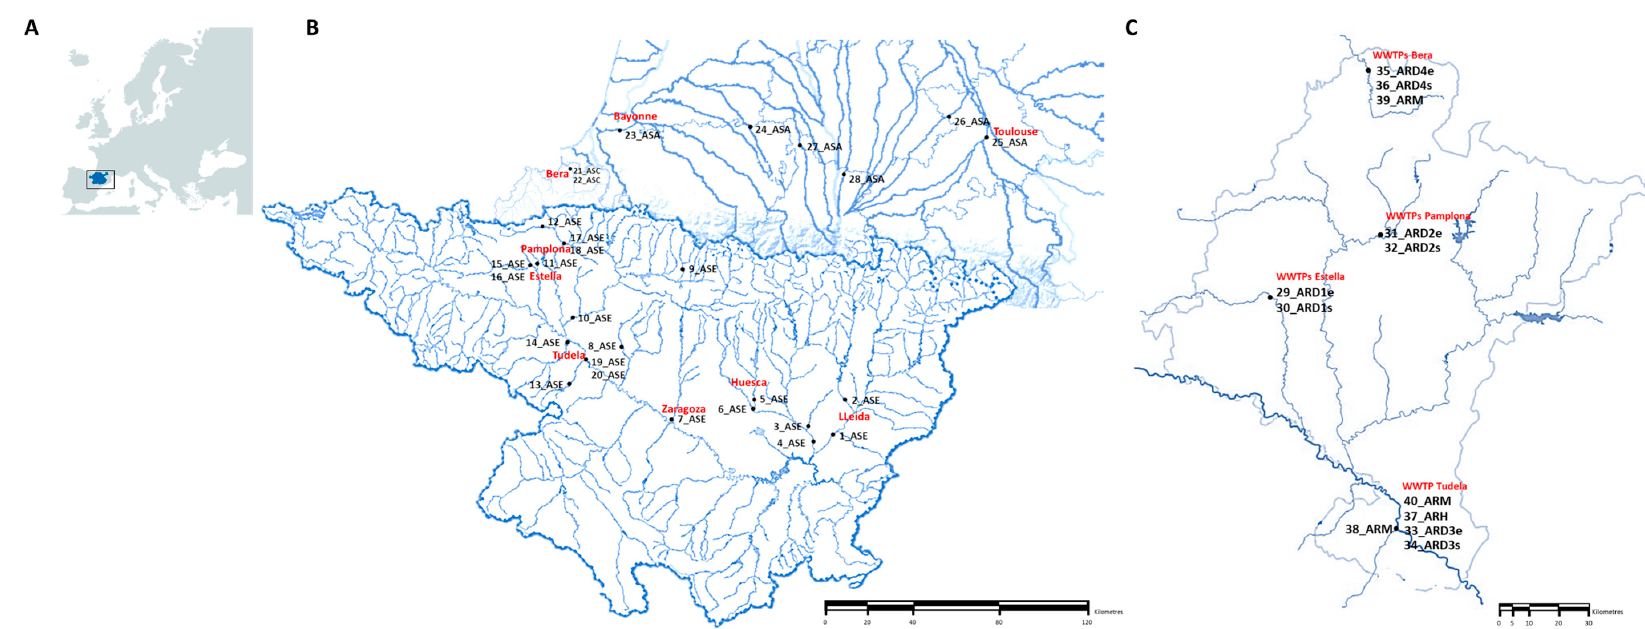
Figure 1 . Geographical location of sampling. ( A ) POCTEFA area (North Spain and South France). ( B ) Sampling points of rivers (ASE: Ebro Basin; ASC: Cantabrian Basin; ASA: Adour-Garonne Basin); ( C ) Sampling points of wastewater treatment plants (WWTPs) and collectors in the Navarra region (ARDe: Discharge of wastewater entering the treatment plant. ARDs: Discharge of wastewater leaving the treatment plant. ARH: Discharge of hospital wastewater. ARM: Discharge of slaughterhouse wastewater) .